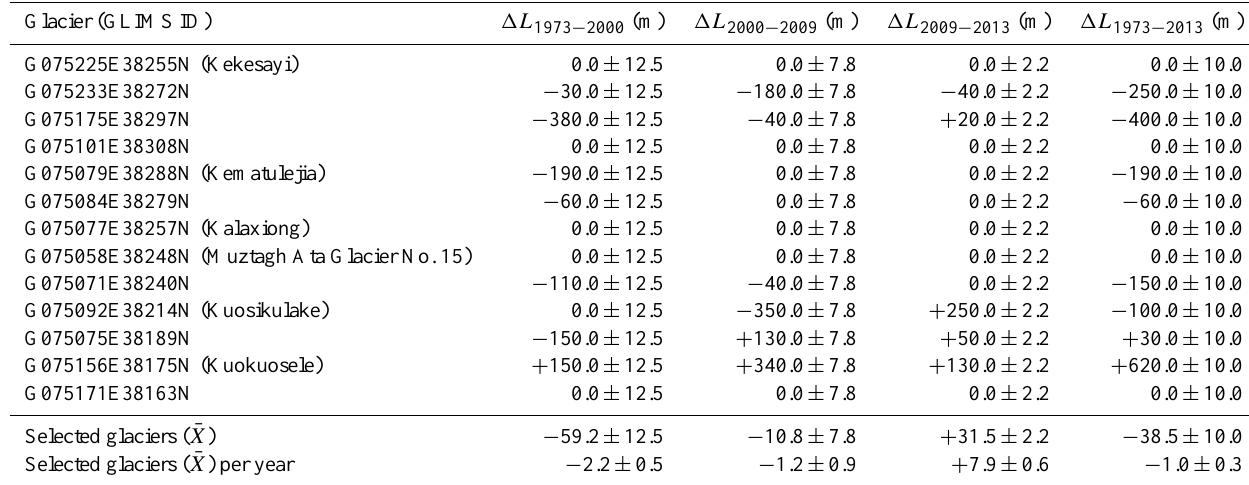
Table 3. Glacier length changes ( (cid:49)L ) at Muztagh Ata for selected glaciers that have mass-balance estimates. Glacier (GLIMS